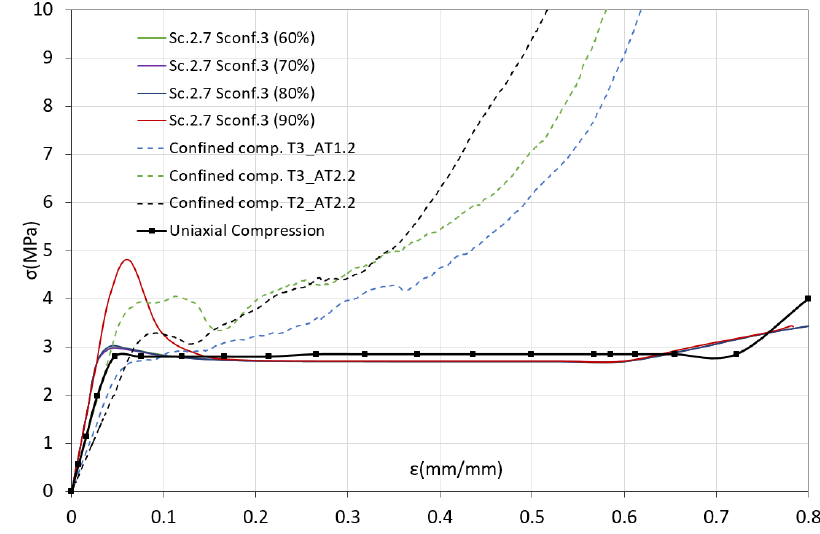
Figure 11. Experimental stress – strain curves (dashed line) vs. numerical (continuous line). Effect of CFV constitutive model parameters in the case of 𝜎 𝑐𝑜𝑛𝑓0 = 3 𝑀𝑃𝑎 .